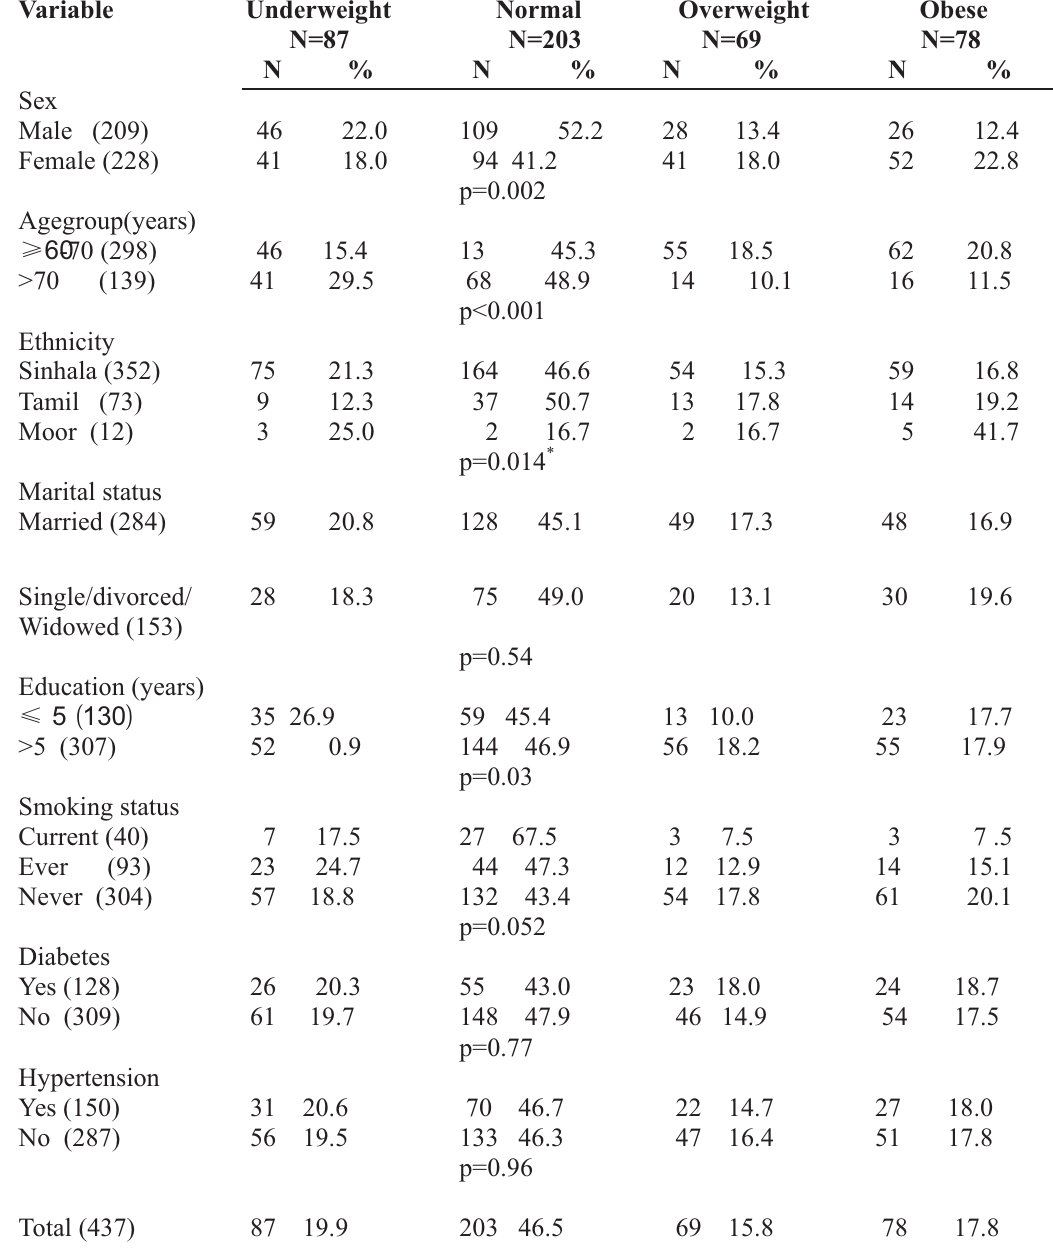
Table 2: Associations between some variables and nutritional status as assessed by the BMI